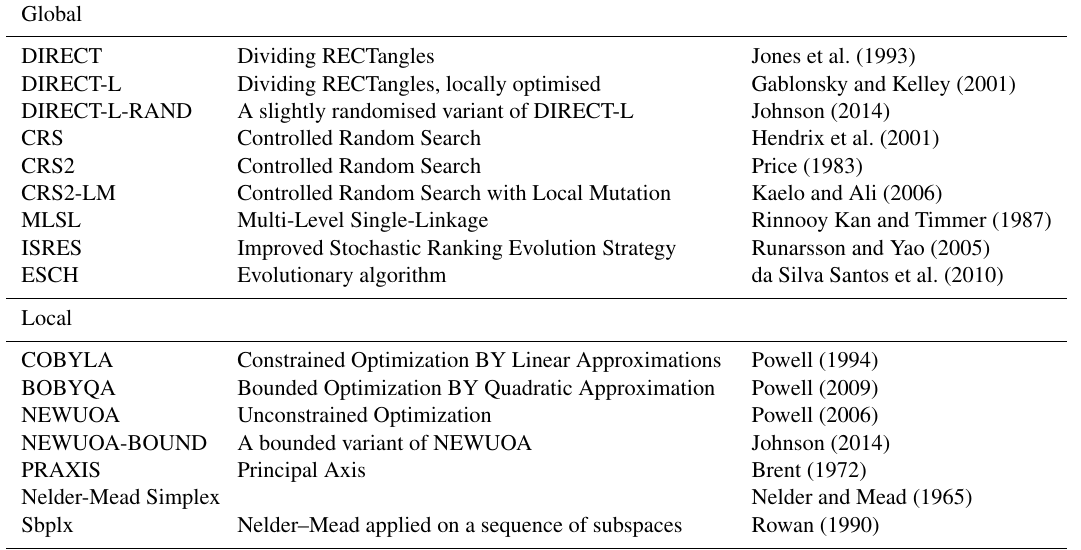
Table 1. Derivative-free optimisation algorithms from the NLopt toolbox supported in the Cyclops optimisation suite.